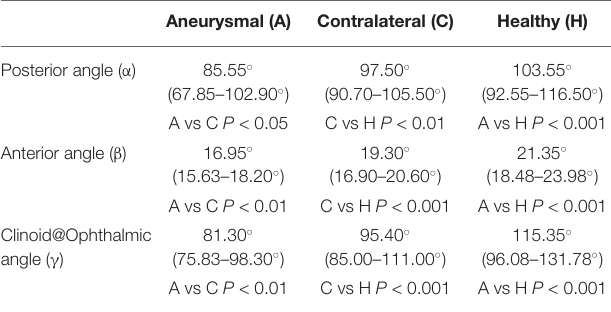
TABLE 2 | Univariate statistical analysis of angles α , β , and γ